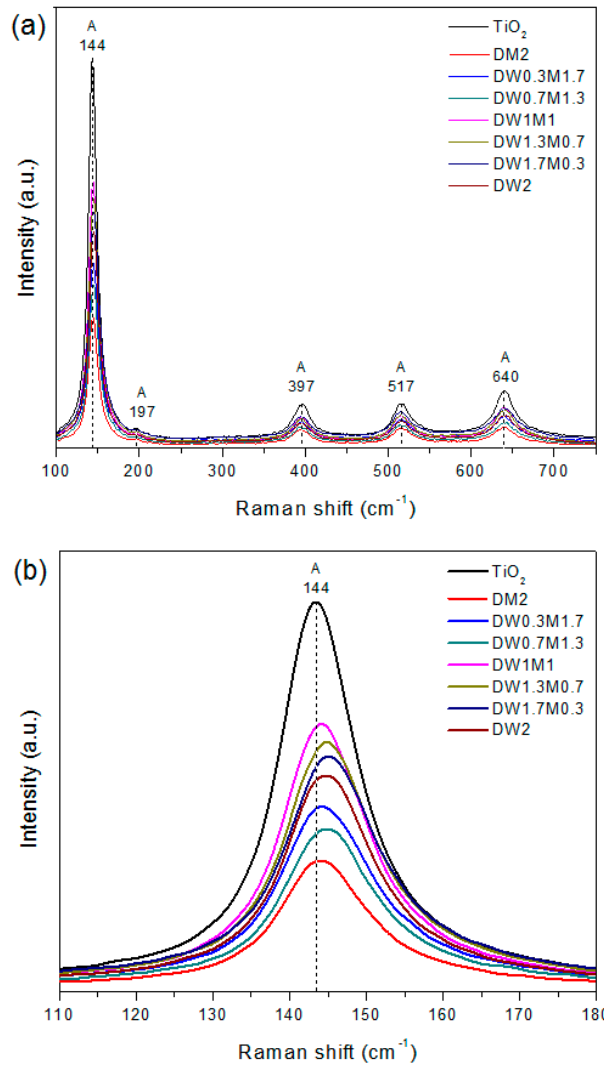
Figure 4. ( a ) Raman spectra and ( b ) Raman peak at 144 cm − 1 of all synthesized materials.